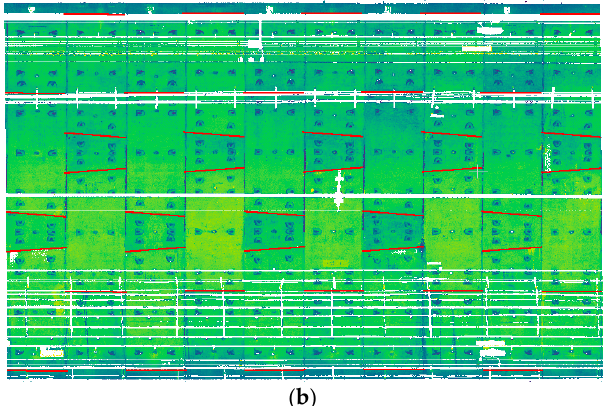
Figure 9. ( a ) Straight-line fitting effect and ( b ) transverse seam positioning effect of cross seam. The center points (a1, a2, b1, b2, c1, c2, d1, d2, e1, e2, f1, f2, g1, g2, h1, and h2) were formed by the clustering of the bolt holes connecting two adjacent rings and were inter- polated to obtain a, b, c, d, e, f, g, and h, respectively, as shown in Figure 10a. The straight- line equation was used to fit and locate the circumferential seam. The positioning effect of the circumferential seam is shown in Figure 10b.